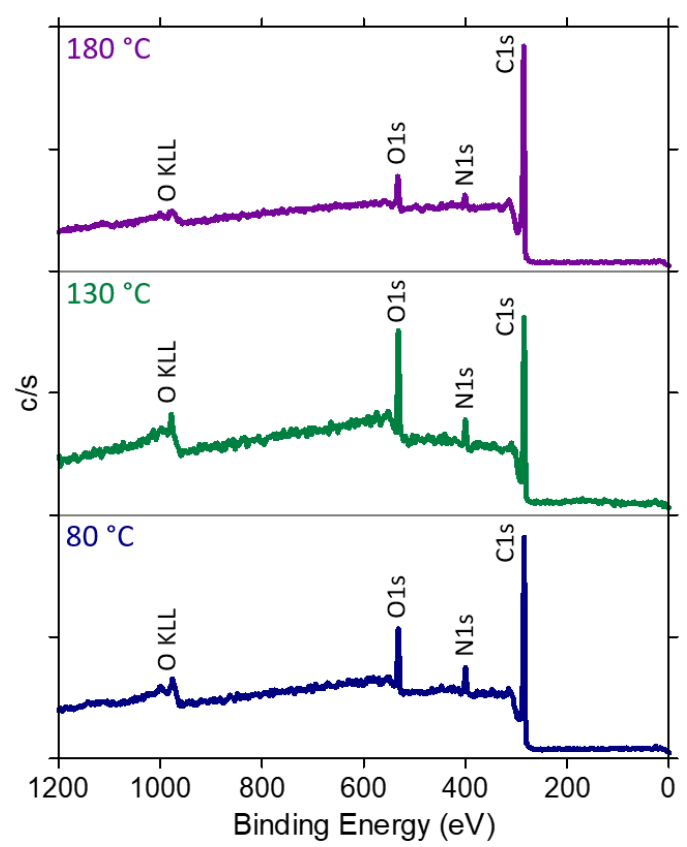
Figure 11. Wide scan XPS spectra of HSAG/TMP equimolar mixtures treated at 80, 130 and 180 ◦ C. The percentage of C, O, and N atoms for pristine HSAG and HSAG/TMP is reported in Table 3. Table 3. Atomic percent concentration and concentration ratios deducted from XPS spectra for pristine HSAG and HSAG/TMP equimolar mixtures treated at 80 ◦ C, 130 ◦ C and 180 ◦ C. Sample